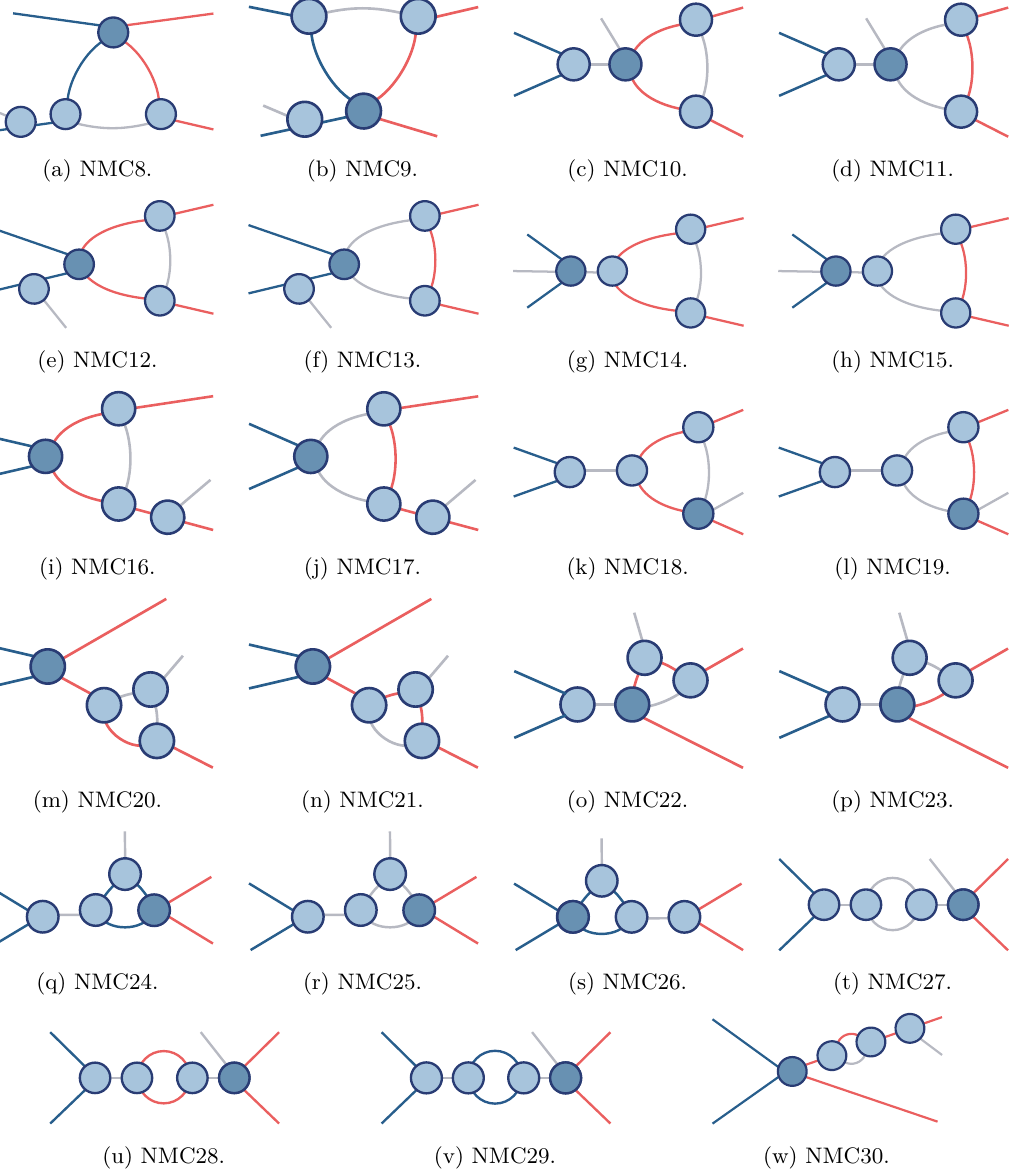
Figure 8 . Next-to-maximal cuts of the one-loop five-point amplitude. Light blue blobs represent three-point amplitudes, darker blobs represent four-point amplitudes, and exposed legs represent on-shell